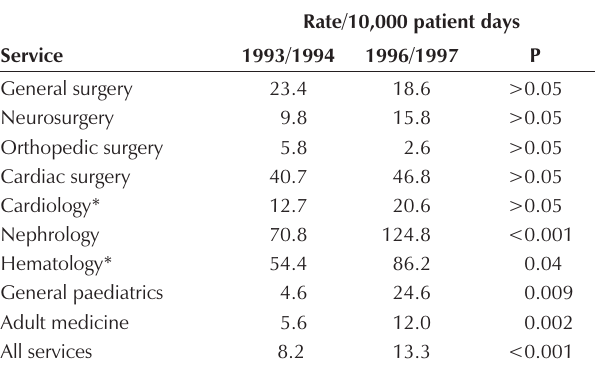
Nosocomial blood stream infections: In the two years before restructuring, 481 nosocomial blood stream infections